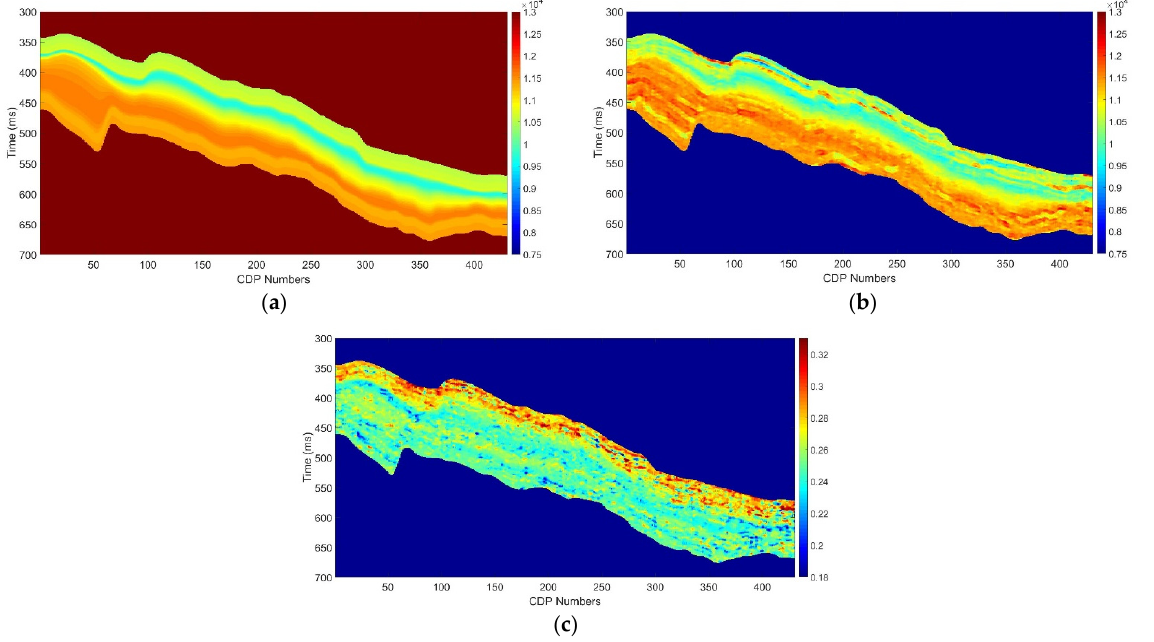
Figure 8. ( a ) Background model ( b ) P-impedance of inverted results ( c ) Poisson’s ratio of inverted results.